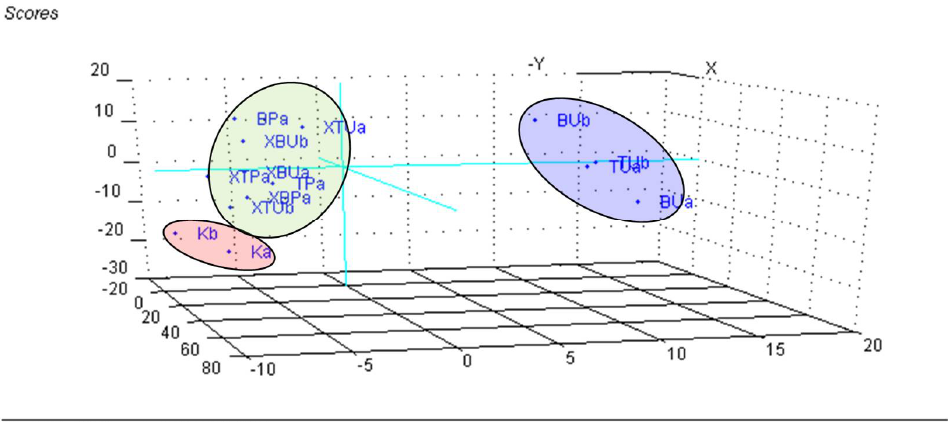
Figure 7. PC 3 versus PC 1 , PC 2 scores plot from the PCA analysis of all FTIR data (both intensities and wavenumbers) of the β-cyclodextrin/unprocessed and processed chicken breast and thigh lipid complexes (codes “XBU”, “XBP”, “XTU” and “XTP”), in comparison with β-cyclodextrin (code “K”) and non-complexed lipid fractions (codes “BU”, “BP”, “TU” and “TP”); “a” and “b” stand for duplicate samples.